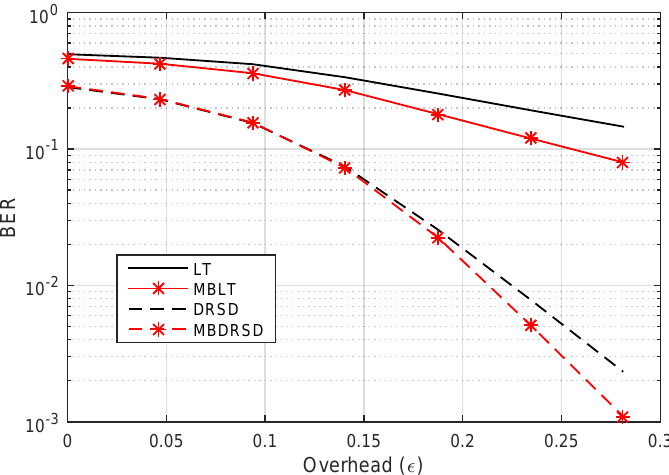
Figure 10. BER versus the overhead ( (cid:101) ) for different coding schemes at k = 256 and erasure probabilities of ε 1 = 0, ε 2 = 0, and ε 3 =